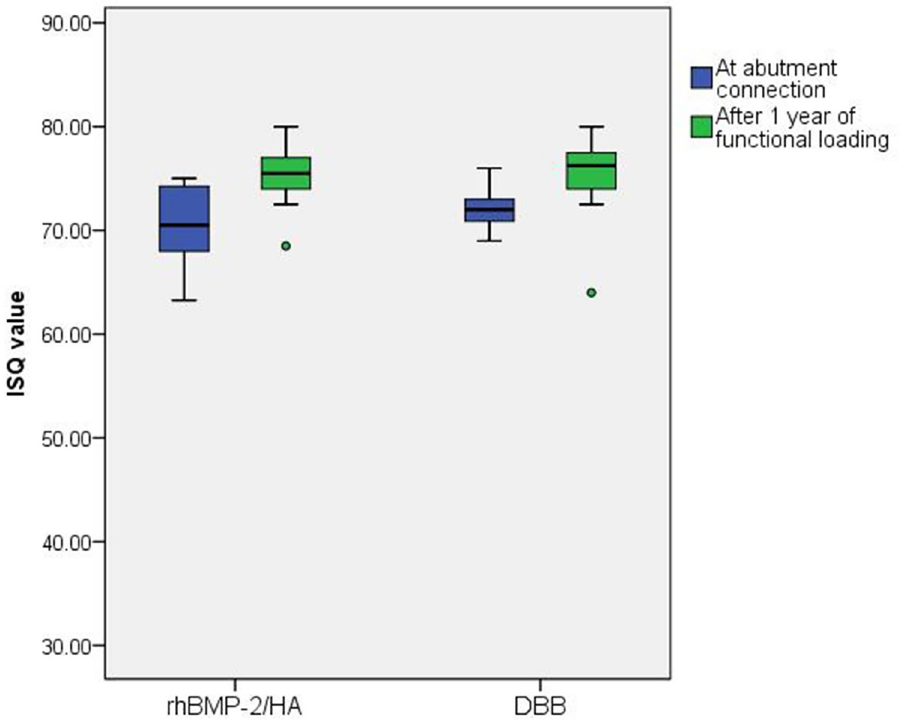
Fig 2. Boxplots presenting ISQ values at abutment connection and after 1 year of functional loading for the rhBMP-2/HA and DBB groups. ISQ, implant stability quotient; rhBMP-2, recombinant human morphogenetic protein 2; HA, hydroxyapatite; DBB, deproteinized bovine